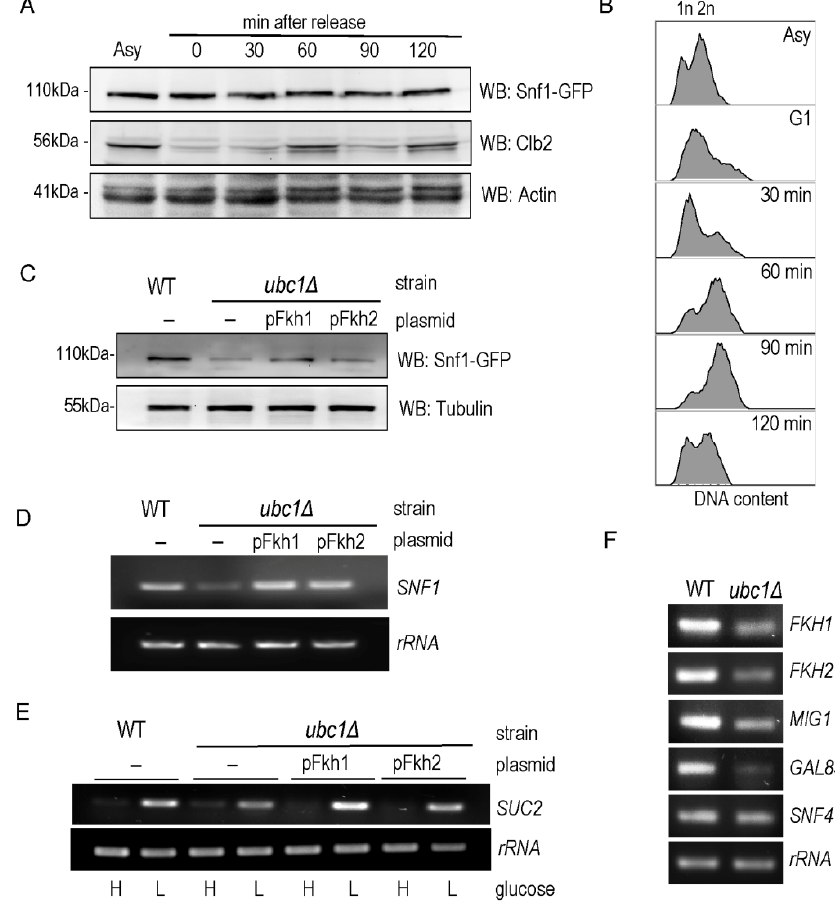
FIGURE 5: Snf1 protein and glucose- responsive SUC2 expression levels